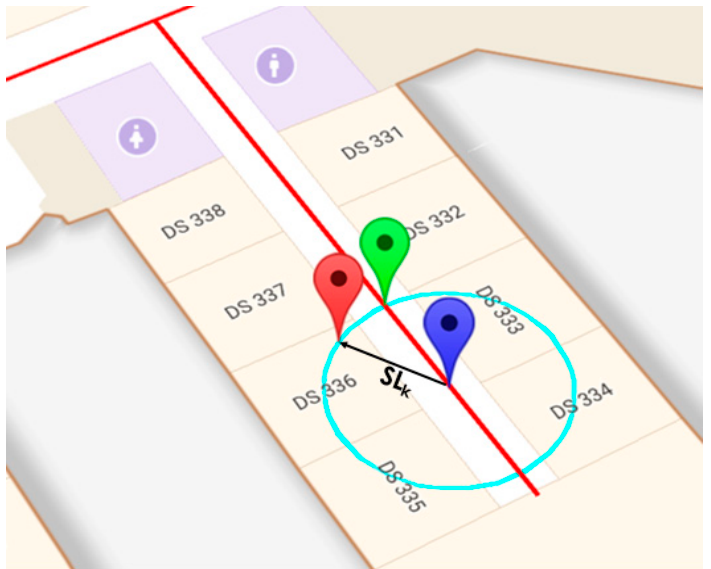
Figure 11. Example of graph-matching. The blue marker denotes the previous position, the red marker the new estimated one from the IMU sensors, and the green marker the one corrected by graph-matching.